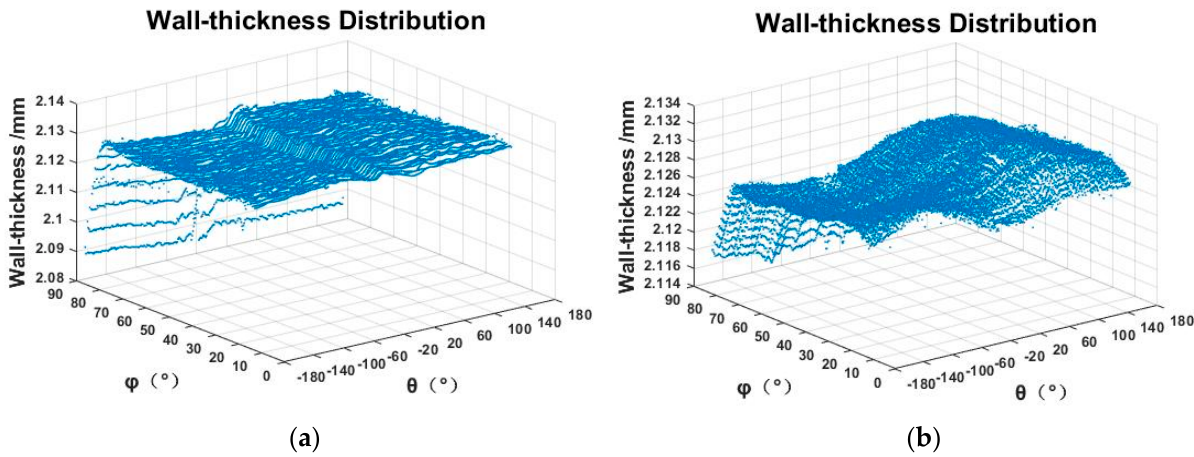
Figure 12. The wall ‐ thickness distribution (polar coordinates): ( a ) the wall ‐ thickness distribution (the meridian trajectory); ( b ) the wall ‐ thickness distribution (the concentric trajectory). Figure 12. The wall-thickness distribution (polar coordinates): ( a ) the wall-thickness distribution (the meridian trajectory); ( b ) the wall-thickness distribution (the concentric trajectory).